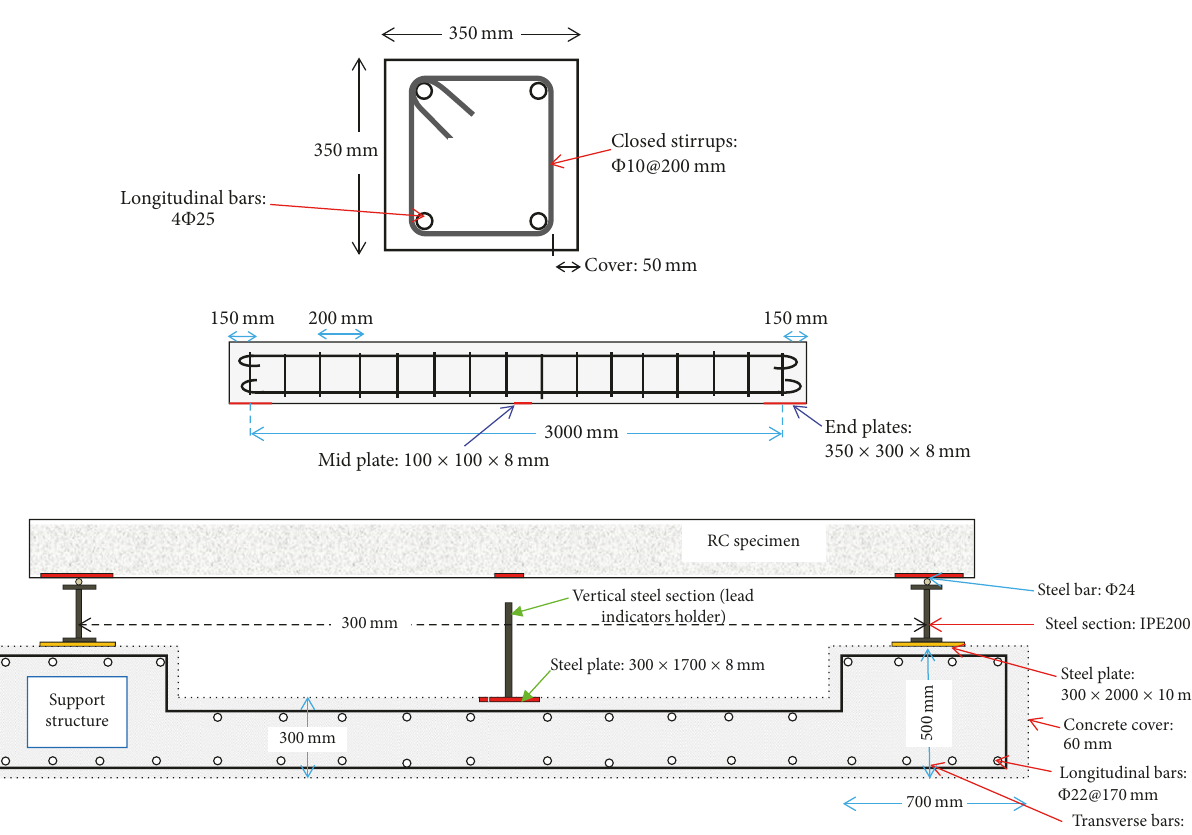
Figure 6: Cross section and reinforcement details of the specimen and support